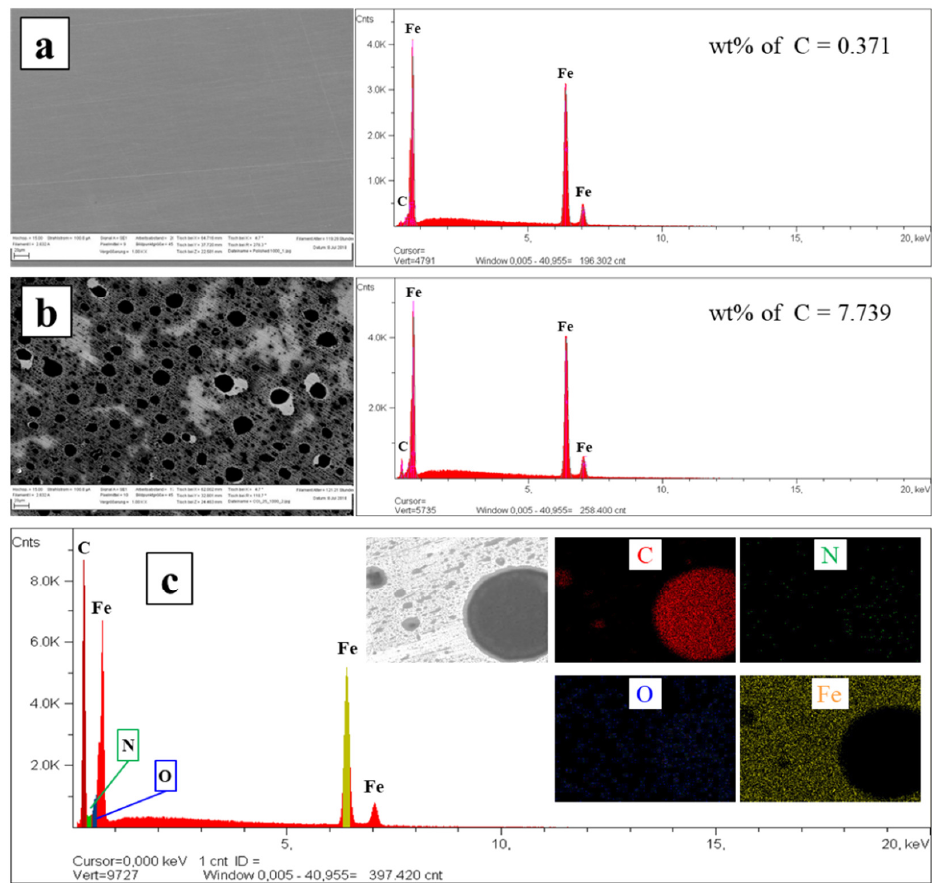
Figure 5. SEM images and EDS spectra for ( a ) blank steel sample as reference; ( b ) inhibitor-immersed steel sample (10 min in C+OI 100 mmol/L) and ( c ) section of a corresponding elemental mapping of ( b ).